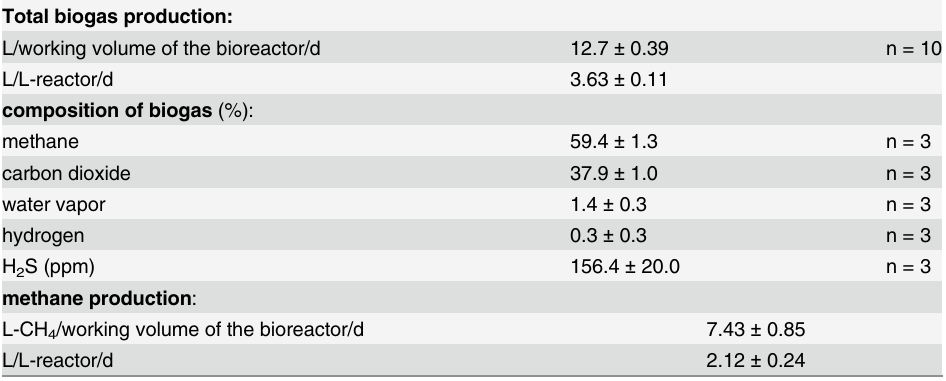
Table 2. Characteristics of biogas generated from the acidic effluent of sugar beet molasses fermen- tation by the methanogenic microbial community in the UASB